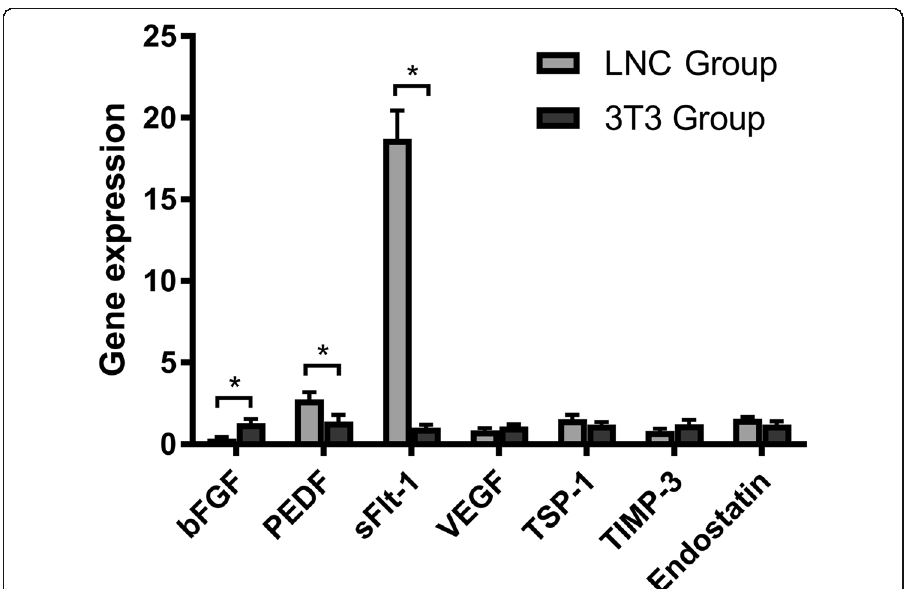
Fig. 5 Relative mRNA expression of the angiogenesis-related factors of cultivated oral mucosal epithelial cells (COMECs) co-cultured with LNCs and 3 T3 cells. The relative genetic expression was investigated by RT-qPCR. β -actin and glyceraldehyde 3-phosphate dehydrogenase were used as internal controls. Data were expressed as mean ± standard deviation. LNCs: limbal niche cells, bFGF: basic fibroblast growth factor, PEDF: pigment epithelium-derived factor, sFlt-1: soluble fms-like tyrosine kinase-1, VEGF: vascular